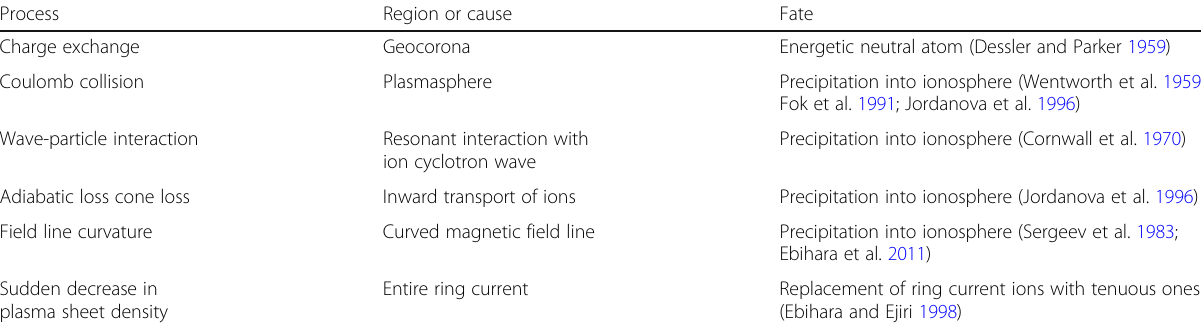
Table 1 Decay processes for ring current (Ebihara and Ejiri 2003)